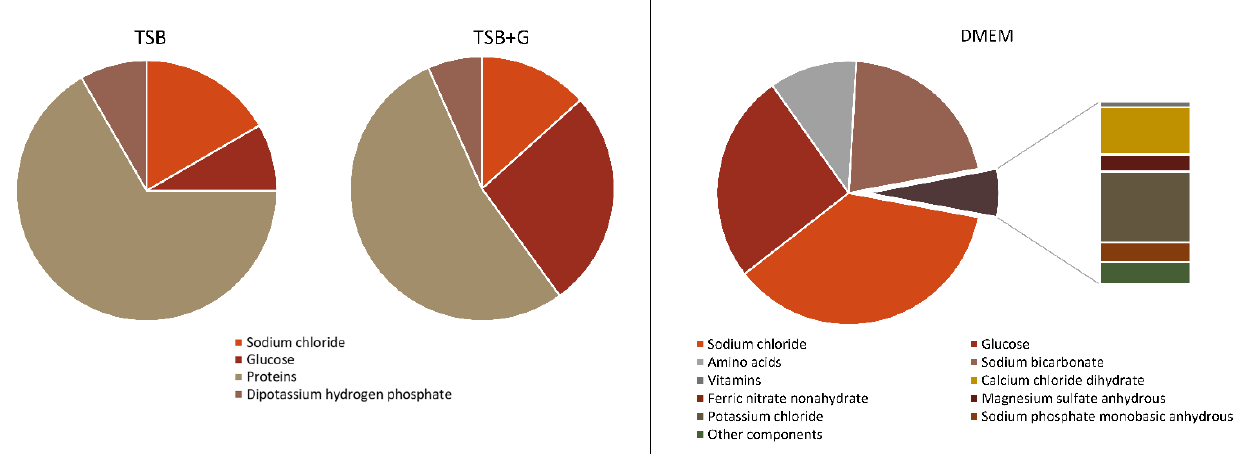
Figure 6. The percentage compositions of three media: tryptic soy broth TSB, tryptic soy broth with 1% glucose TSB + G, and Dulbecco ’ s Modified Eagle Medium